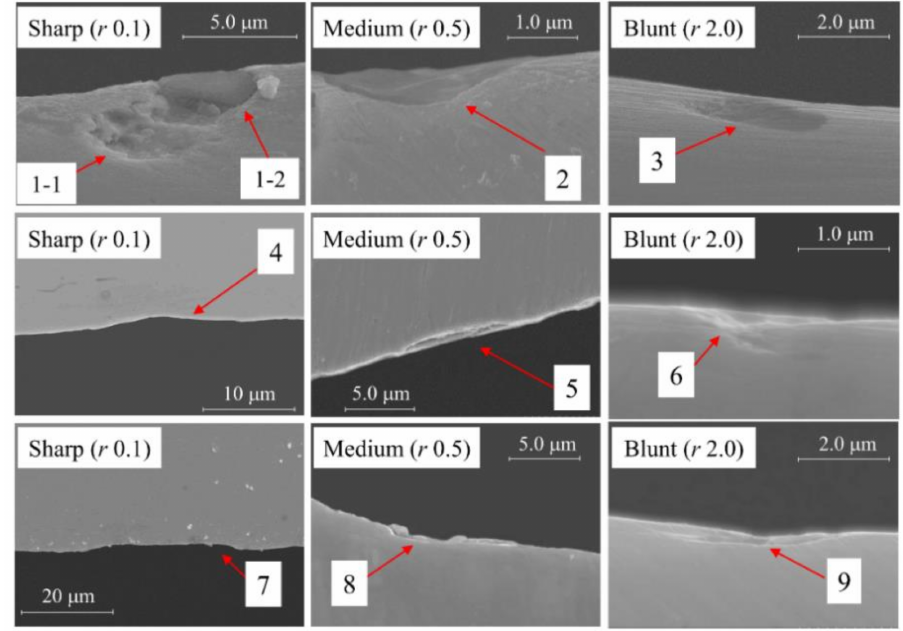
Figure 5. Captured SEM images; images of 1st row correspond to specimen 1 (135 h), images of 2nd row correspond to specimen 2 (432 h), and images of 3rd row correspond to specimen 3 (708 h).